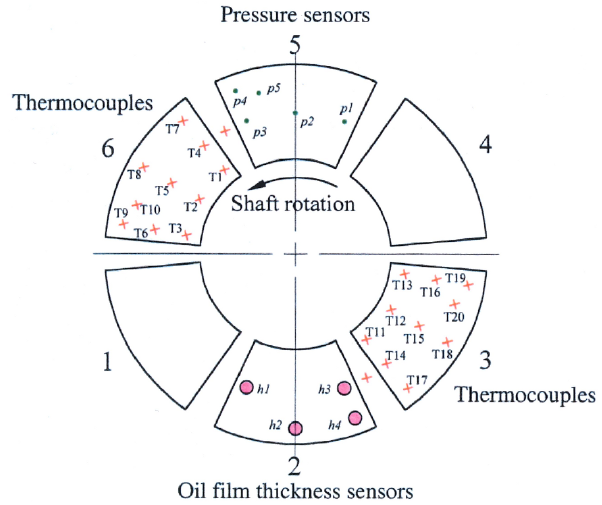
Figure 16: Location of the bearing mounted sensors (Glavatskikh, 2000; Glavatskikh and Lars- son,